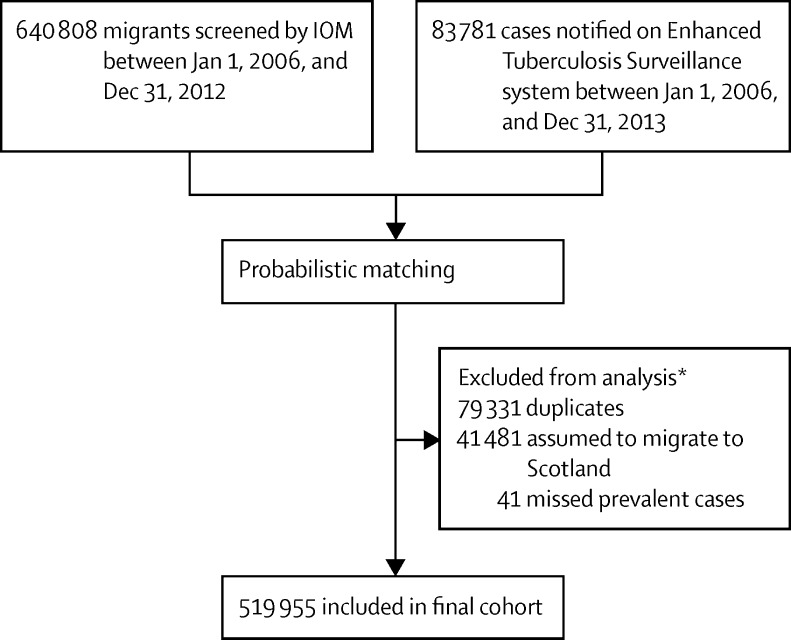
Study participant flow chartIOM=International Organization for Migration. *Numbers assumed to migrate to Scotland varied by imputation, and the sum of those excluded does not equal the difference between total visa applicants and the number of migrants included in the final cohort, because groups were not mutually exclusive.